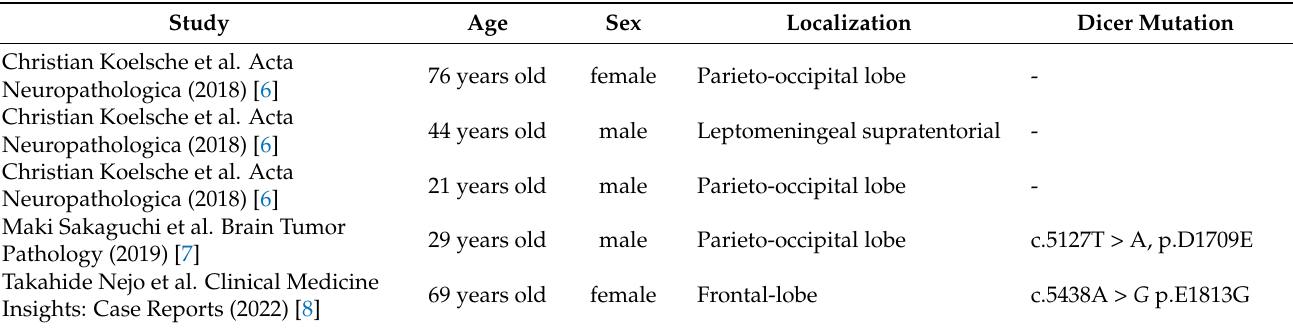
Table 1. Literature review of adult primary intracranial sarcoma DICER1 mutant.